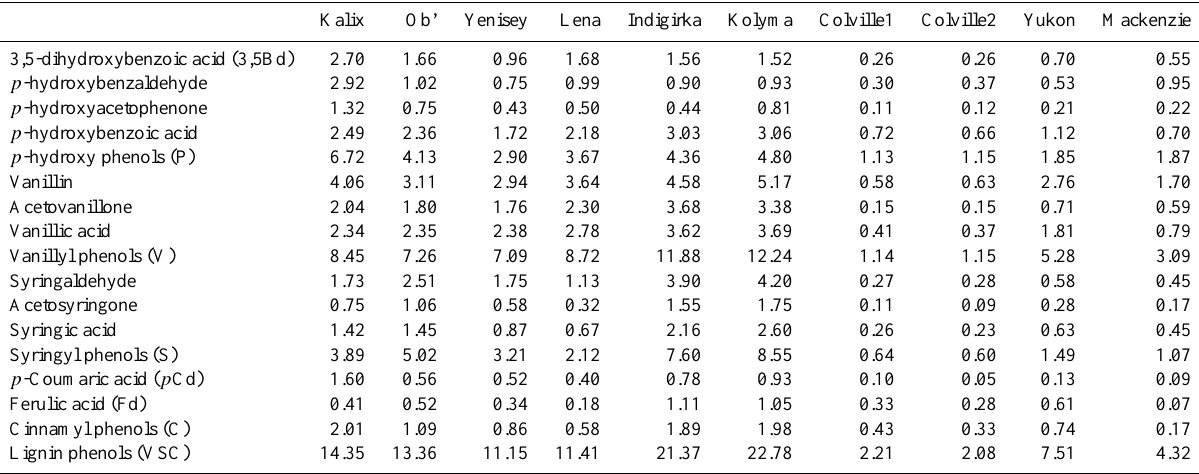
Table 2. Abundances of lignin and hydroxy phenols in the pan-Arctic sediments (mgg − 1 OC). Kalix Ob’ Yenisey Lena Indigirka